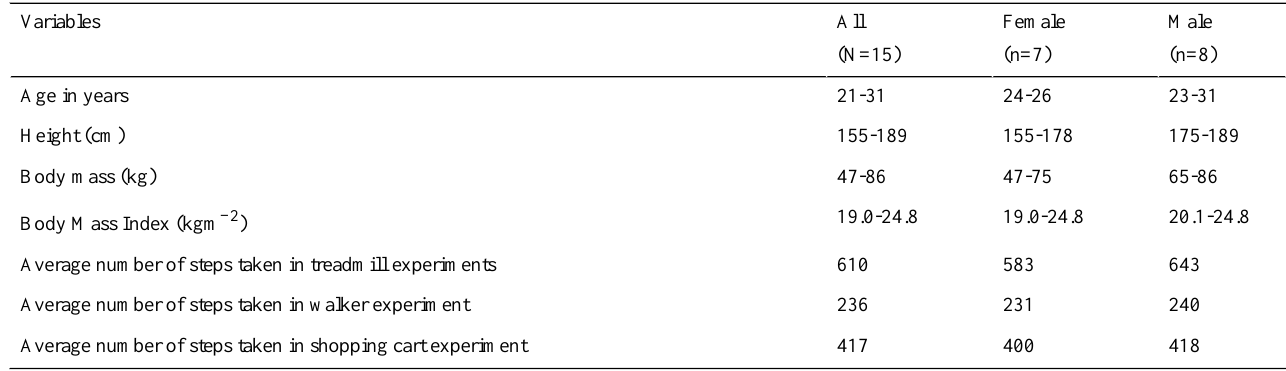
Table 1. Physical and demographical characteristics of the participants.